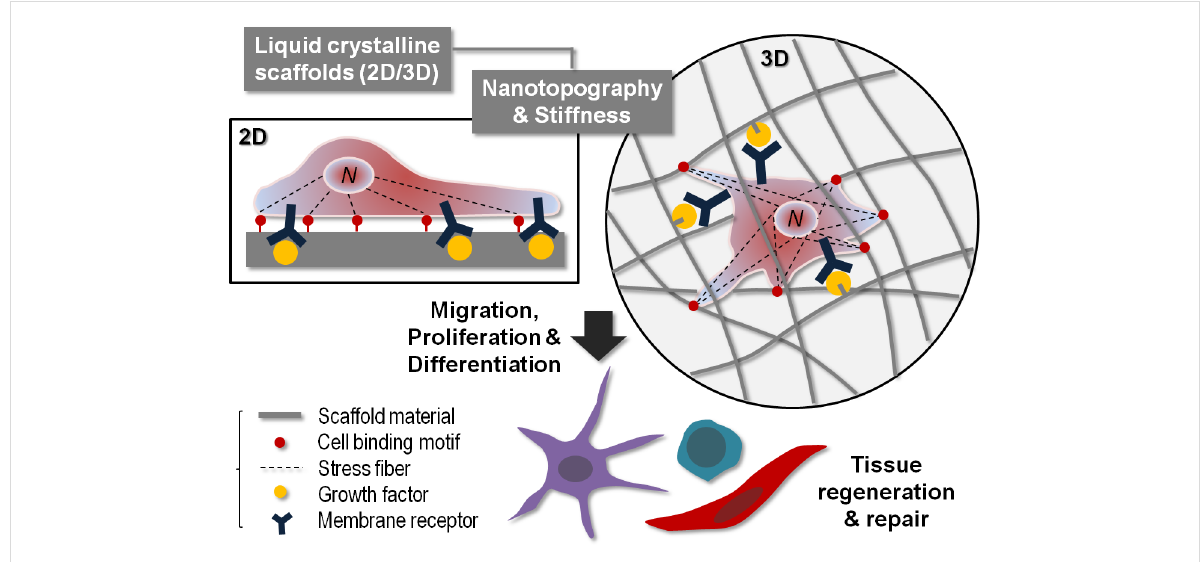
Figure 3: Physicochemical cues in tissue engineering scaffolds for controlling cellular responses. Cells may be attached on the 2D surface or embed- ded in the 3D structure. The cell behavior is governed by the physical factors (2D/3D topography and mechanical stiffness) and the biochemical factors (cell binding and molecular stimulation). The mechanical feedback from the scaffold is transmitted to the cell nucleus (N) via actin bundles (stress fibers). The chemical signal is generated by growth factors and then transduced by transmembrane receptors. By regulating physicochemical cues in the scaffold, the cell migration, proliferation, and differentiation can be controlled suitable for clinical